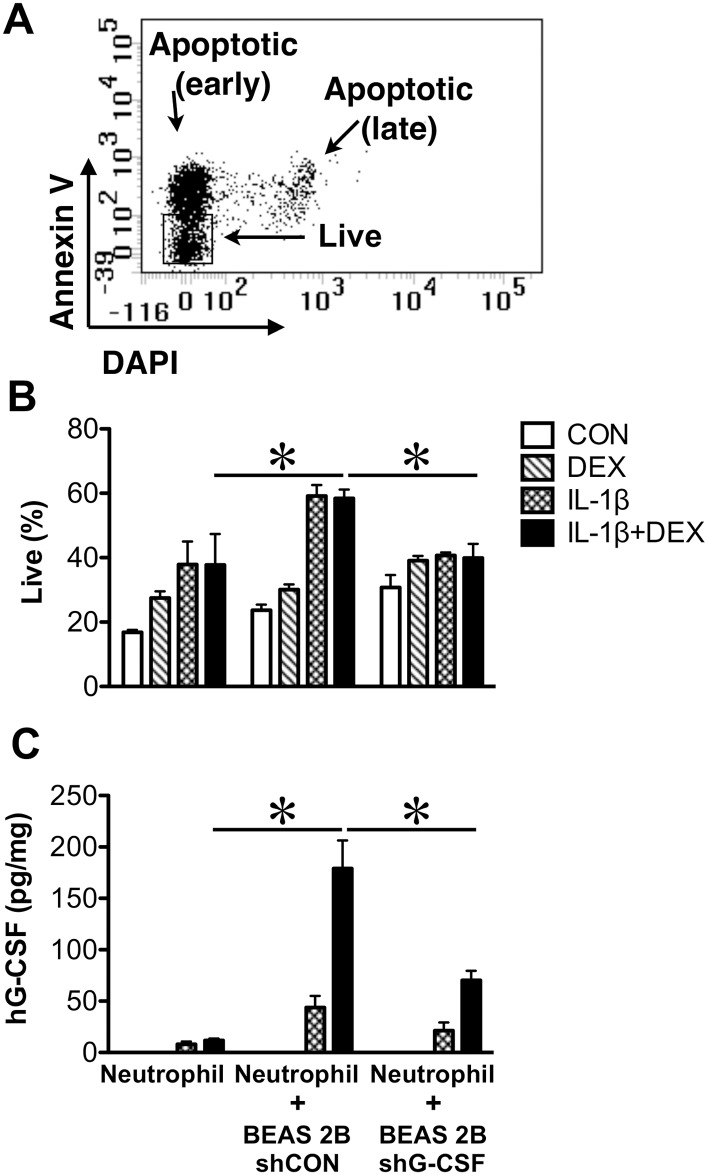
G-CSF induced by glucocorticoid and IL-1β prevents neutrophil apoptosis.(A) A representative dot plot of flow cytometric analysis of human neutrophil spontaneous apoptosis 20 h post harvest. Live (annexin V-DAPI-), early apoptotic (annexin-V+DAPI-), and late apoptotic (annexin V+DAPI+) cells were over 97% of the total cells. Necrotic cells (annexin V-DAPI+) were negligible. (B). BEAS 2B cells expressing control shRNA (shCON), but not those expressing shRNA for hG-CSF (shG-CSF), protected human neutrophils from spontaneous apoptosis in coculture experiments. BEAS 2B cells or culture media were incubated with vehicle (CON), DEX (10 nM), IL-1β (0.3 ng/ml), or IL-1β+DEX for 24 h before the addition of neutrophils, which were cultured for another 20 h. (C). G-CSF levels in the cell culture media from (B). ✽, significantly different, two-way ANOVA followed by Bonferroni post-hoc tests. P<0.05 (N = 5). The comparisons shown are between the IL-1β+DEX treated cultures indicated.